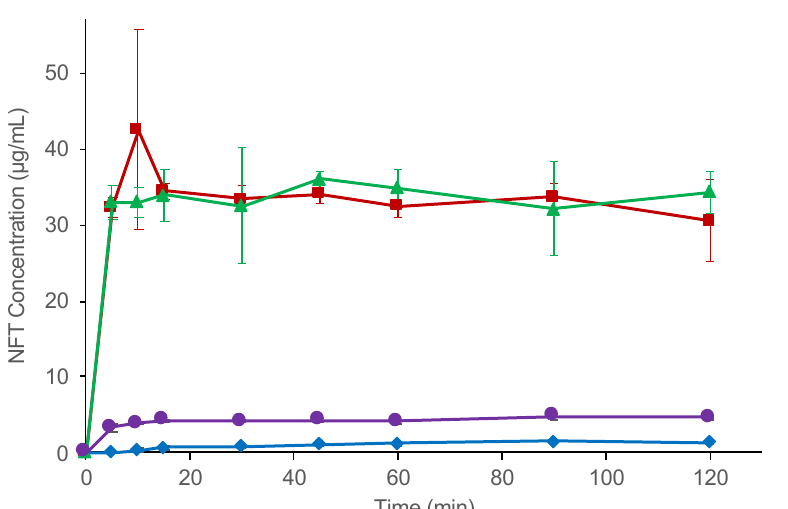
Figure 5. Non-sink dissolution study of crystalline NFT and NFT ASDs. Symbols: crystalline NFT ( ◆ ), PVPVA ASD ( ■ ), HPMCAS ASD ( ▲ ), and Eudragit ASD ( ● ).